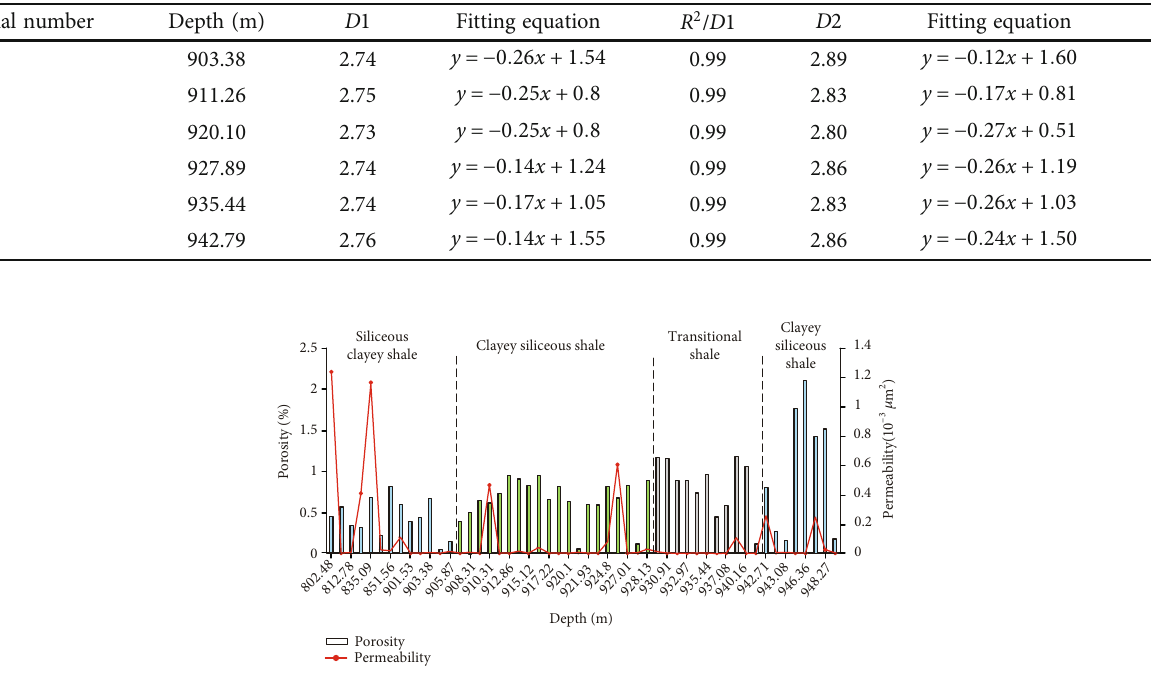
Figure 8: Pore and seepage characteristics of the Longmaxi Formation